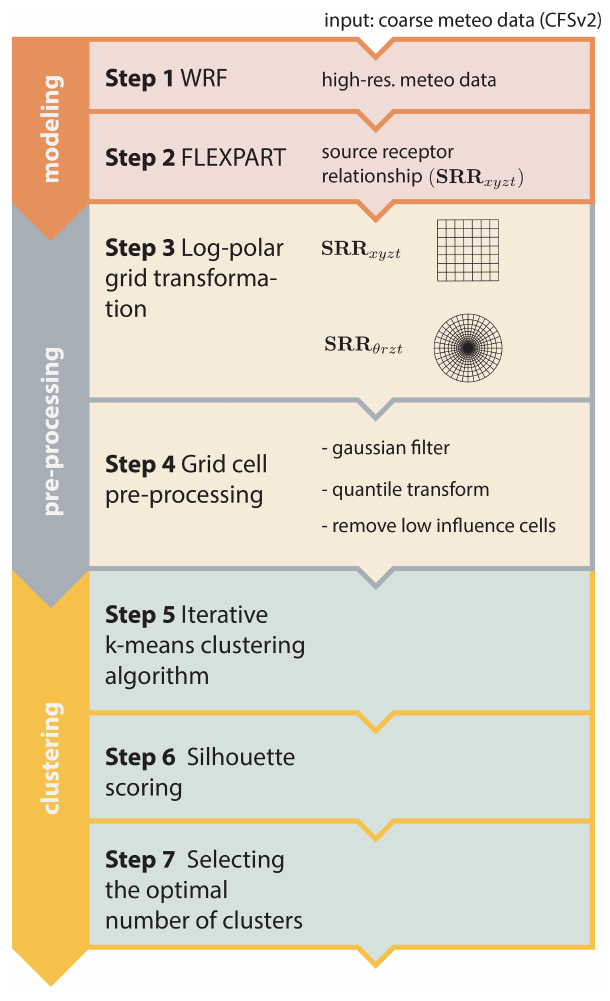
Figure 1. Flowchart describing the method’s steps. The steps are divided into three groups: modelling, pre-processing and clustering. SRR refers to the source–receptor relationship (explained more in Sect.